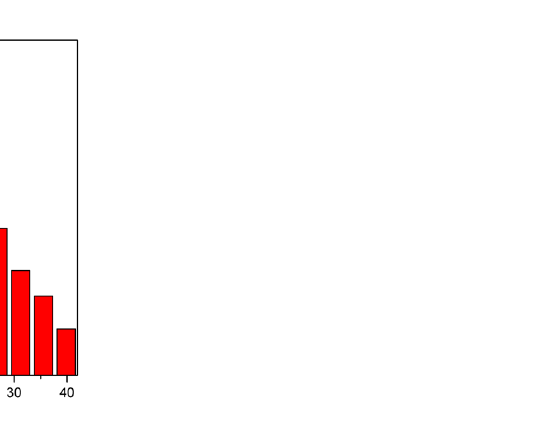
Figure 9. The ESP surface of HPIP molecule srtucure. The corresponding maxima and minima have been labelled in the surface.